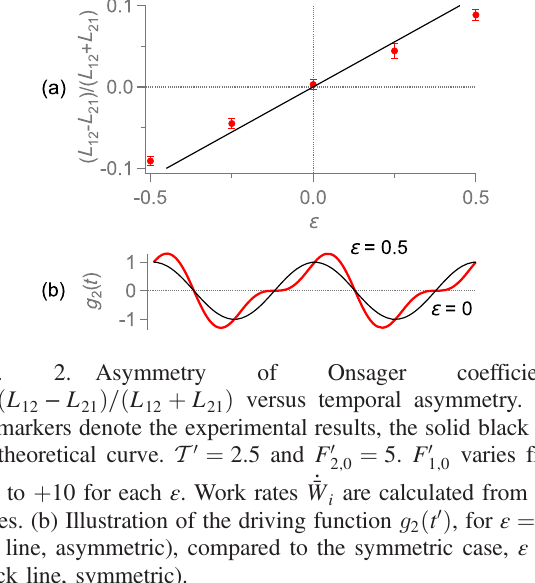
¼ 5 . F 0 1 ; 0 varies from ; 0 are calculated from 150 i